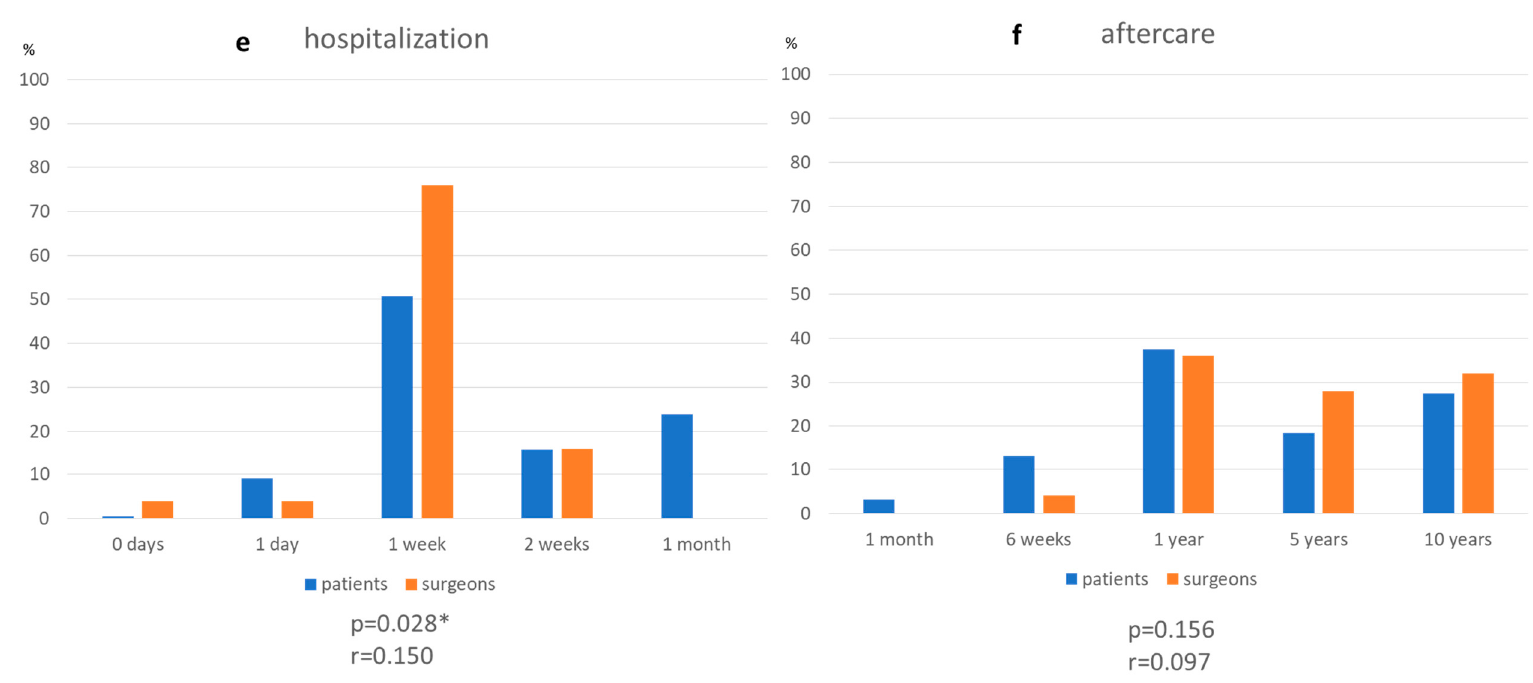
Figure 5. Patients’ acceptance for 100% shoulder stability and surgeons’ perspective with regard to length of scar ( a ), immobilization ( b ), physiotherapy ( c ), pain ( d ), hospitalization ( e ) and aftercare ( f ). (* p ≤ 0.05).